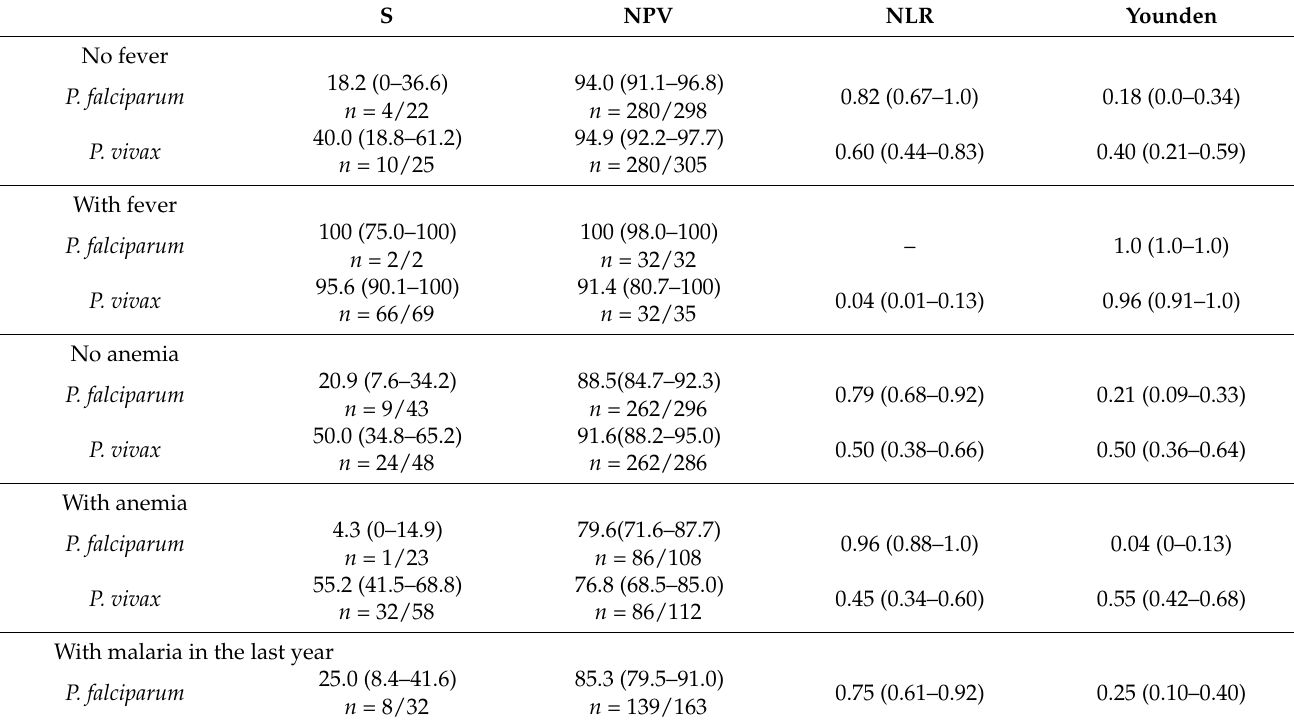
Table 4. Diagnostic accuracy parameters of the TBS against qPCR for Plasmodium falciparum and Plasmodium vivax in pregnant women according to symptoms and history of